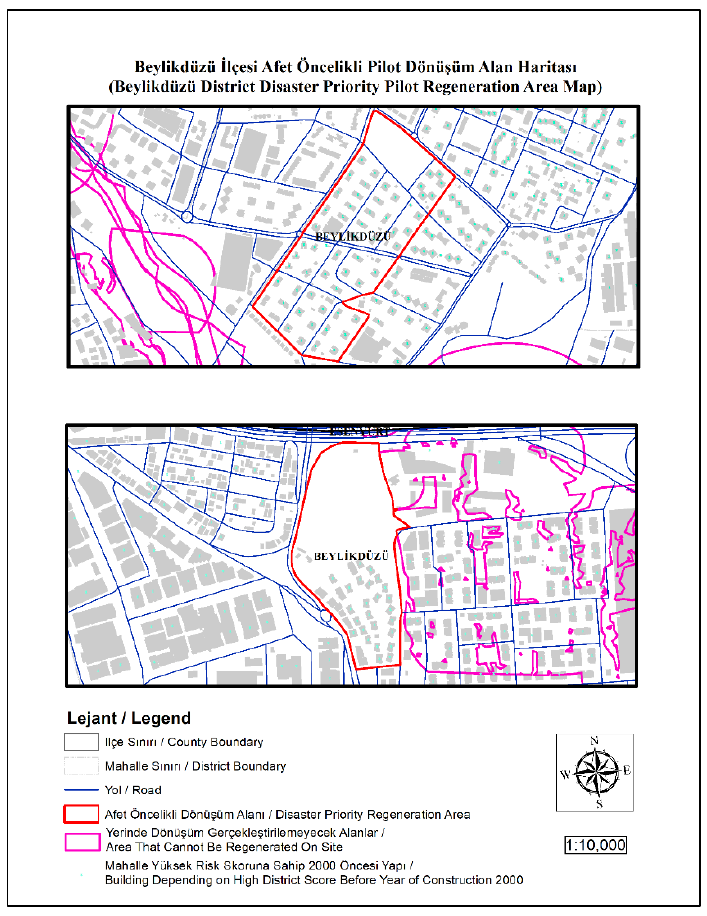
Figure 21. Beylikdüzü District Disaster Priority Pilot Regeneration Area Map.